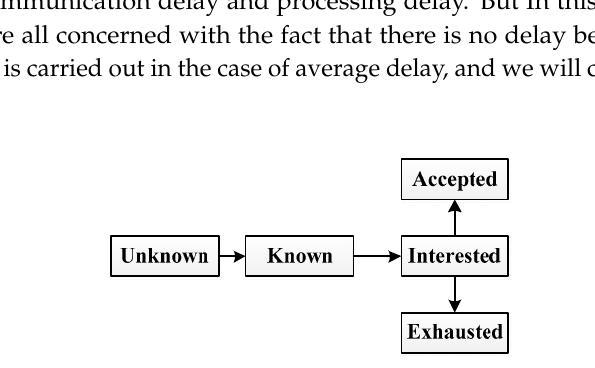
Figure 1. Dependent Cascade Model for Viral Marketing.